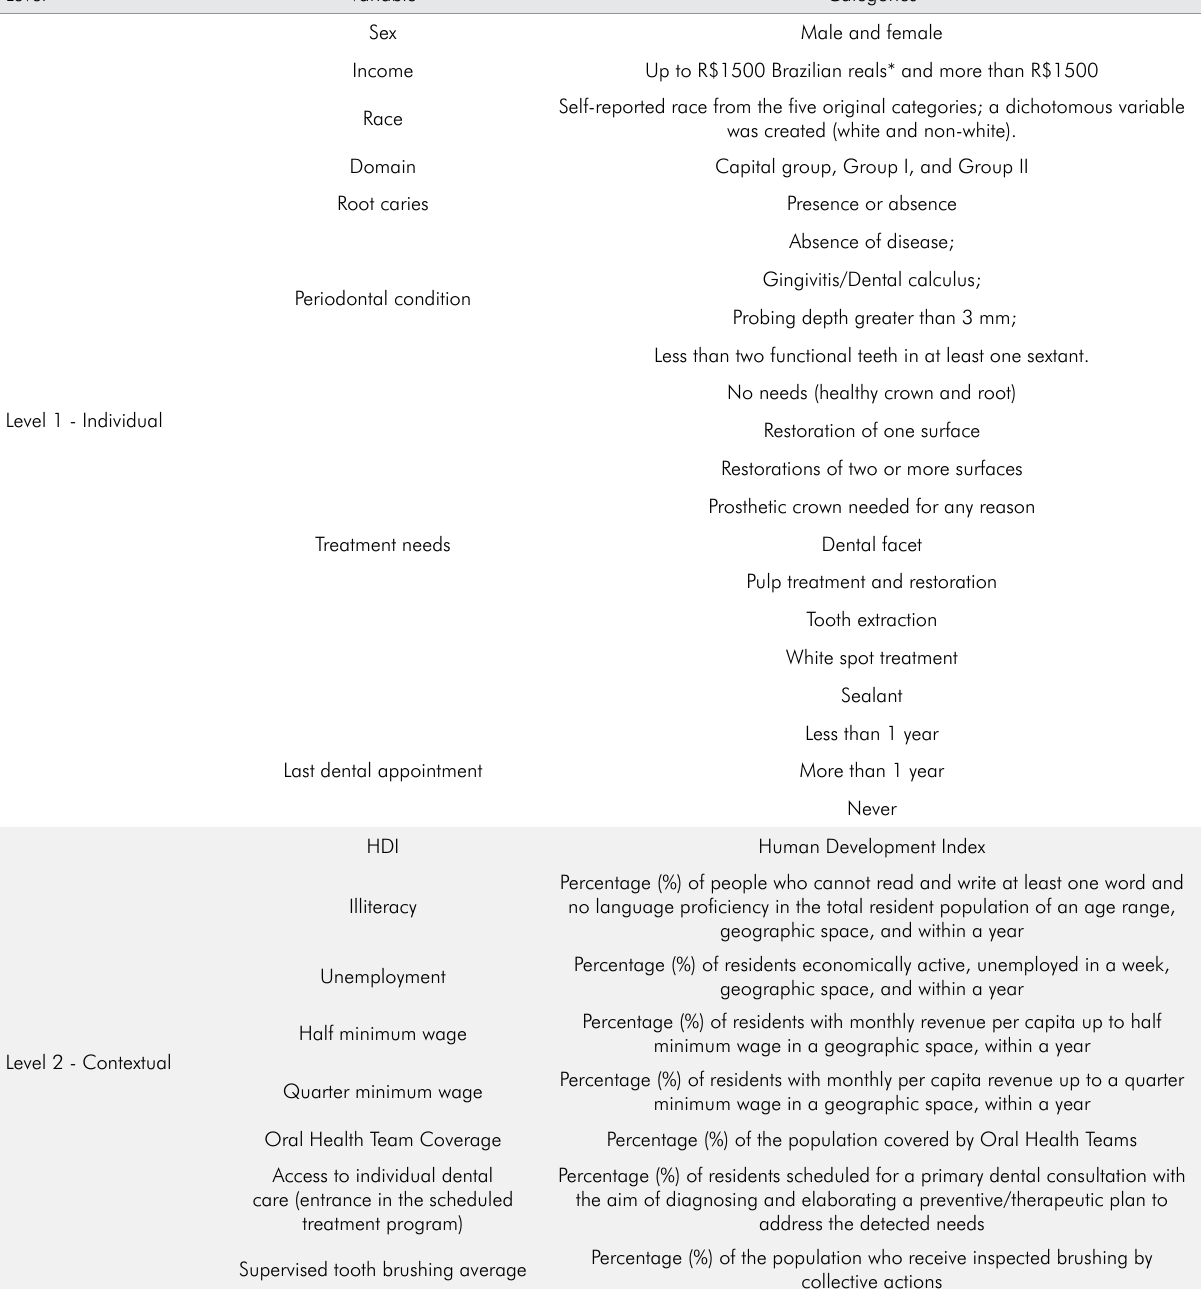
Table 1. Description of variables according to the level of analysis - SB Minas Gerais, Brazil, 2012.